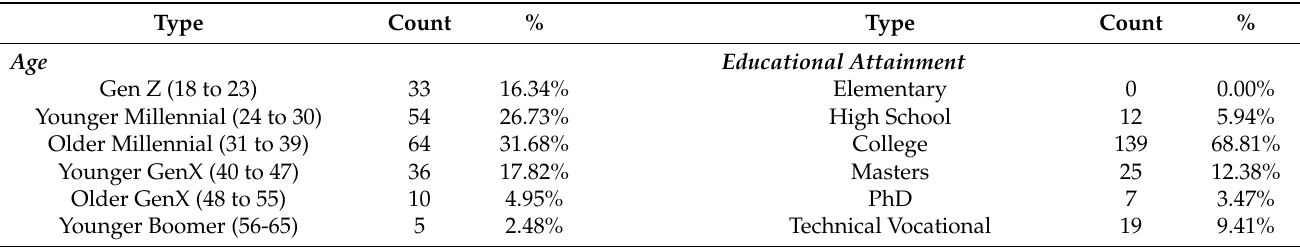
Table 2. Summary of subjects’